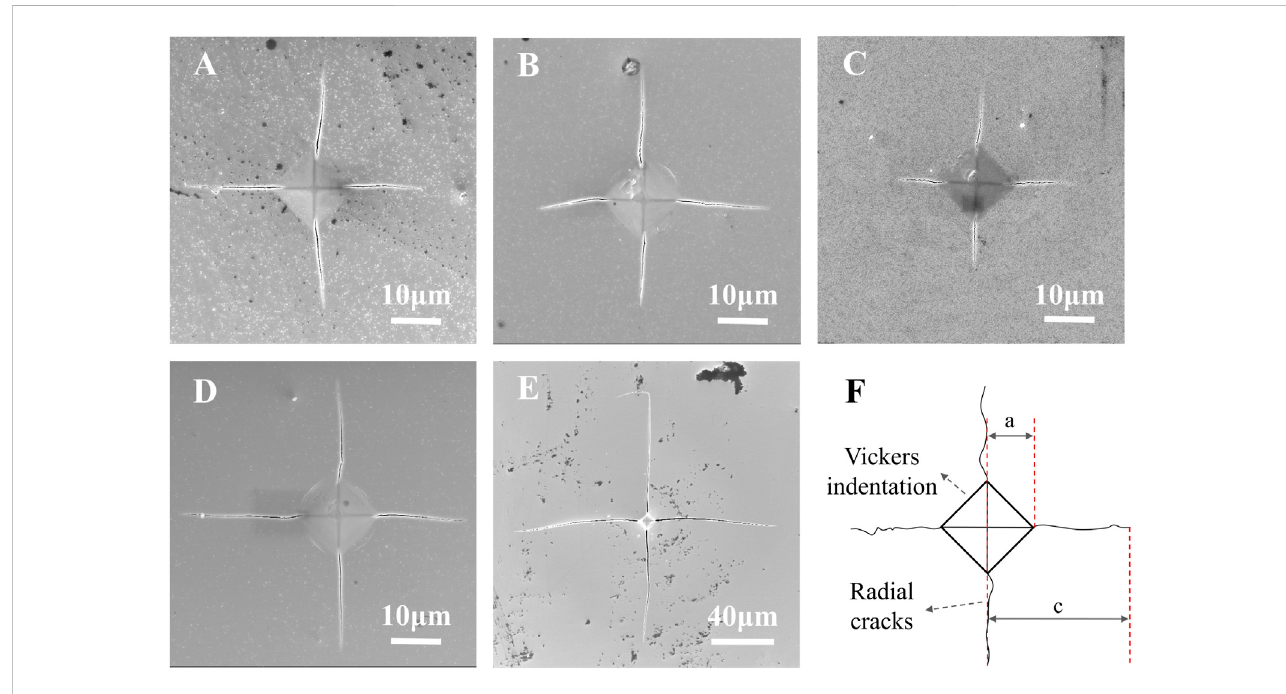
FIGURE 7 VickersindentationmorphologiesoftheZrNiTiMoRHEA fi lmsonSisubstratedepositedatdifferentsputteringpower: (A) 90 W, (B) 120 W, (C) 150 W, (D) 180 W, (E) 210 W, and (F) an illustration of radial cracks.